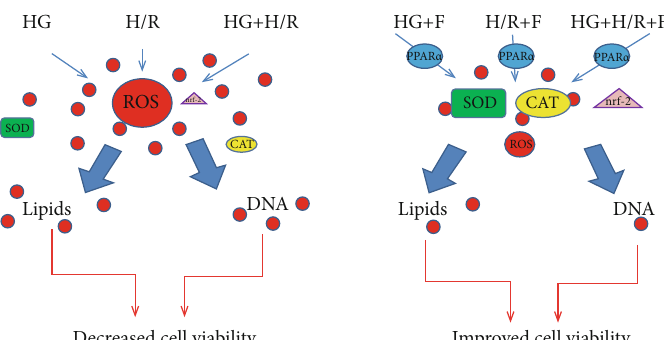
Figure 11: A schematic diagram proposing the mechanism of action of feno fi brate in H/R, HG, and HG+H/R in cardiomyocyte cell